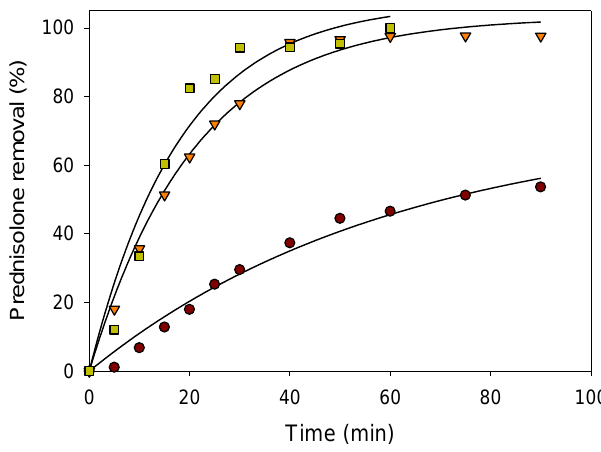
Figure 9. Effect of PS concentration on the removal of prednisolone: 0.1 mM (●), 0.5 mM ( ▼ ), 1 mM ( ■ ). Line (-) represents the fit of the experimental data to pseudo -first order kinetic equation. Experimental conditions: [prednisolone]= 25 mg·L −1 , [catalyst] = 30 g·L −1 .